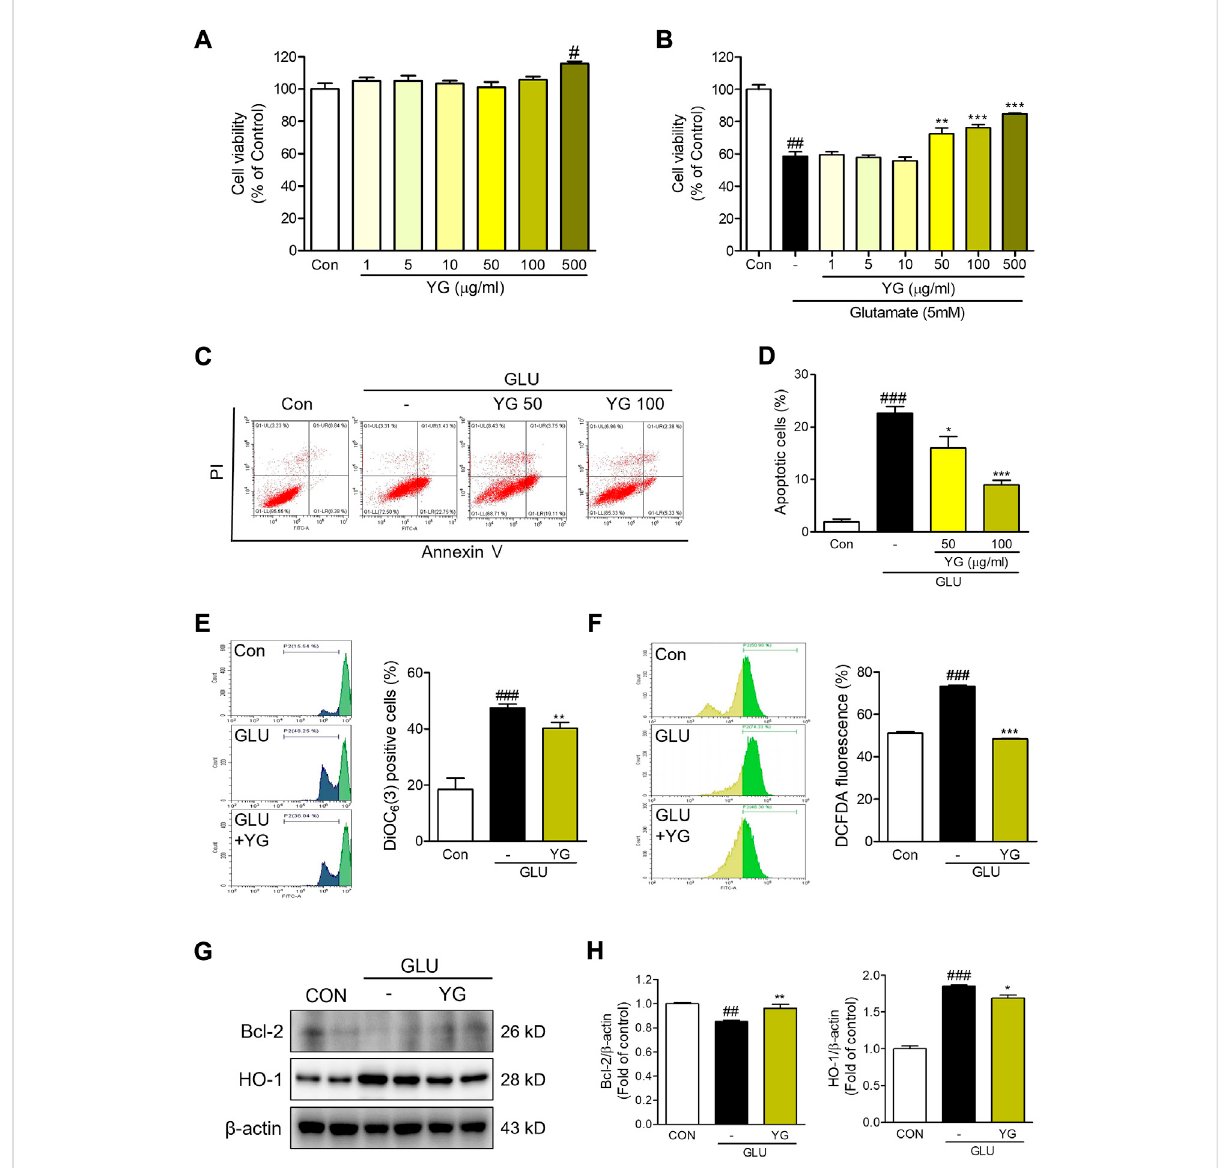
FIGURE 3 Neuroprotective effects of YG against glutamate-induced cytotoxicity in HT22 cells. (A , B) Cell viability. The results are calculated as a percentage of result values in control. (C) Representative fl ow cytometry analysis and (D) histogram for annexin V/PI staining. Representative fl ow cytometry analysis and histogram for (E) DiOC6(3) and (F) carboxy-H 2 DCFDA. (G) Western blot and (H) its densitometric analysis for Bcl-2 and HO1. All data are presented as the mean ± SEM from more than three independent experiments. # p < 0.05, ## p < 0.01, ### p < 0.001 vs. CON; * p < 0.05, ** p < 0.01, *** p < 0.001 vs. GLU. CON; control, GLU; glutamate 5mM, YG; Yuk-Gunja-tang 100 μ